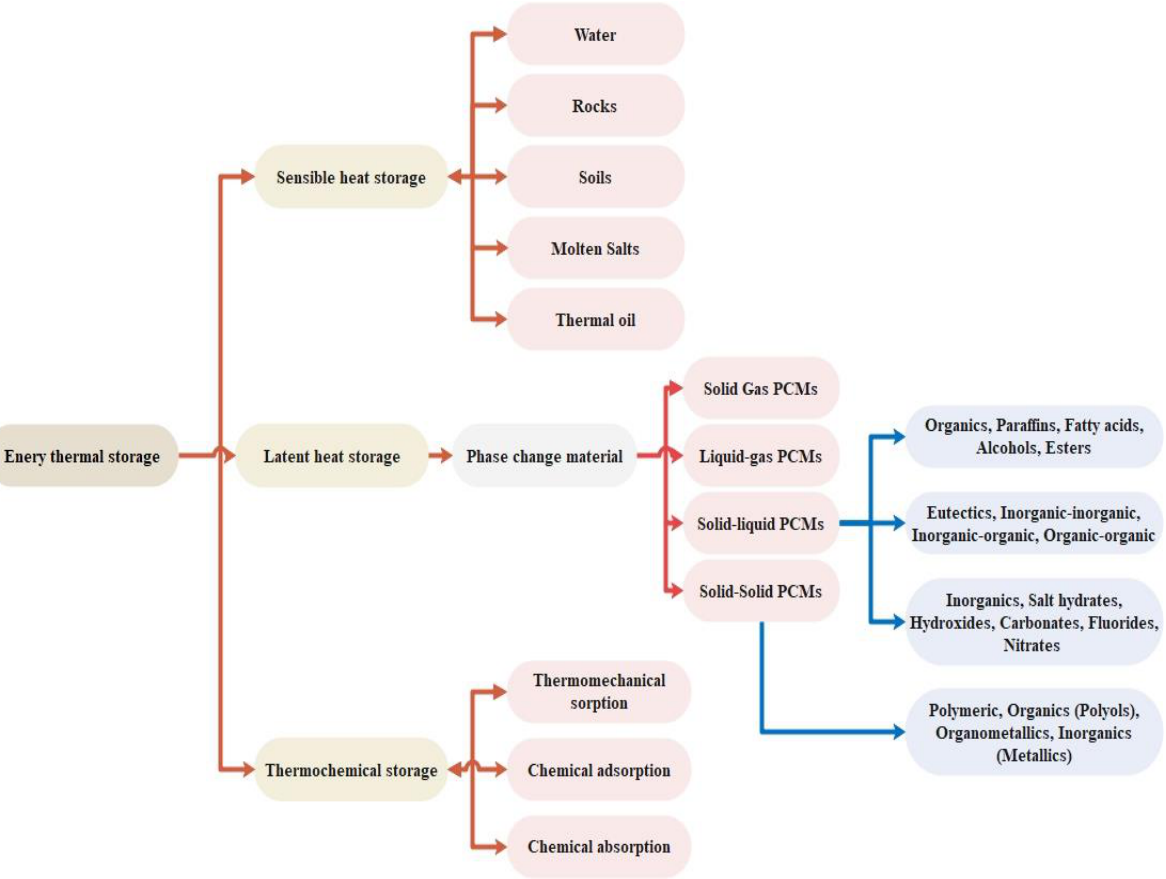
Figure 1. Thermal storage methods and materials that are commonly used.